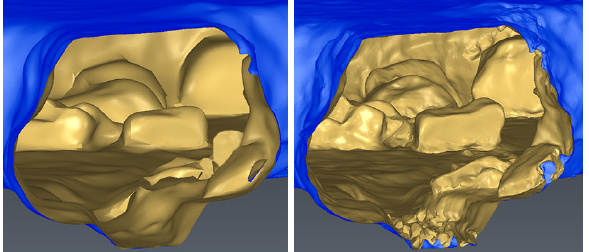
Figure 8 . Comparison between the mesh obtained with different levels of